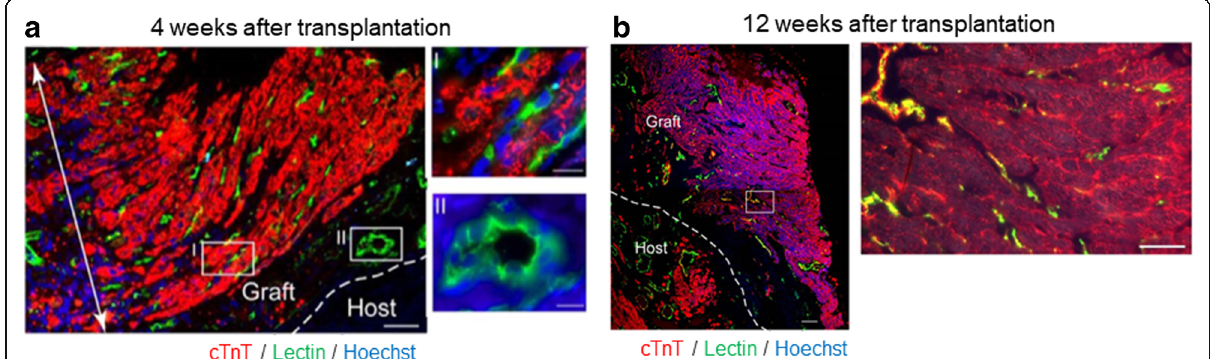
Fig. 1 Vascular network formation after mouse embryonic stem cell-derived thick cardiac tissue sheets with gelatin hydrogel microsphere. cTnT immunostaining for lectin (represents perfused vasculature)-perfused rat heart. Cardiomyocytes (cTnT, red), perfused vessels (lectin-stained, green), and pre-stained graft nuclei (Hoechst, blue). a Four weeks after transplantation. Note that thick regenerated myocardium (double-headed arrow) supported by dense perfused capillary networks (green) were formed. Capillaries (I) and larger vessels (II) in the graft (green) were largely Hoechst-positive. b Twelve weeks after transplantation. High magnification image of white box in the right panel. A compact myocardial tissue with capillary vessels was formed. cTnT, cardiac troponin T. Scale bars 100 μ m in ( b ) (left), 50 μ m in ( a ) and ( b ) (right), 10 μ m in ( a ) (I-II). Referred from reference no. 13 with